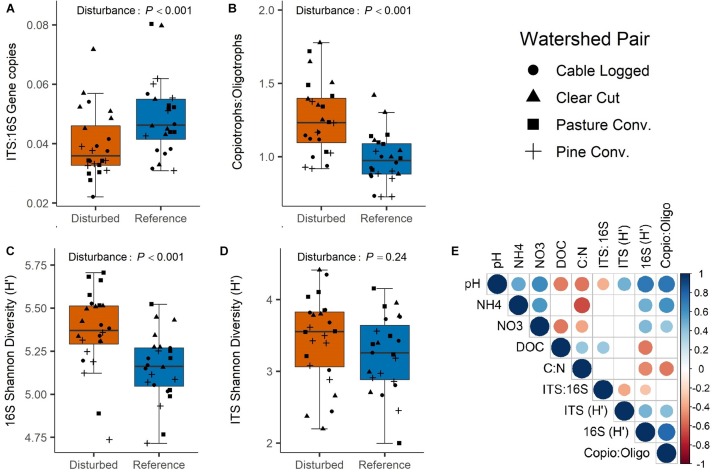
Effects of disturbance on ITS:16S gene copies (A), bacterial Copiotroph:Oligotroph ratios (B), 16S Shannon Diversity (C), and ITS Shannon Diversity (D). P-values are overall disturbance effects from two-way ANOVA. Correlogram (E) visualizes Spearman rank correlation coefficients between microbial variables from panels A to D and key soil variables (only statistically significant correlations shown, P < 0.05).